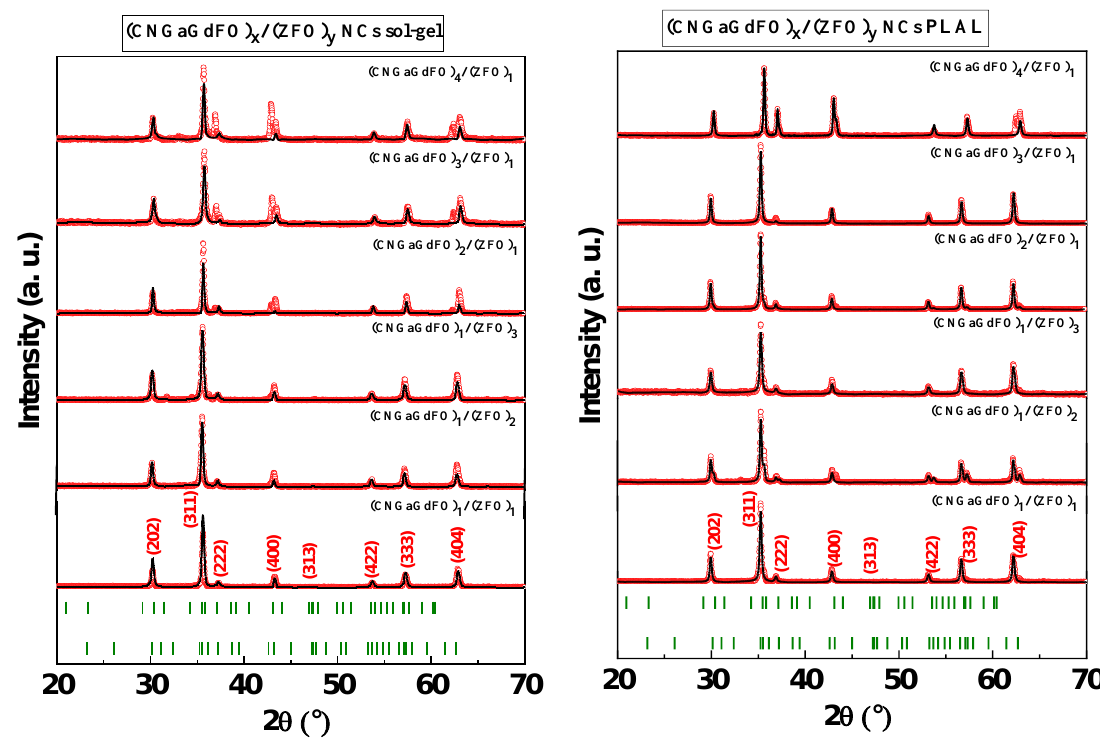
Figure 1. XRD of (CNGaGdFO) x /(ZFO) y ( x:y = 1:1, 1:2, 1:3, 2:1, 3:1 and 4:1) NCs prepared by sol-gel and PLAL.